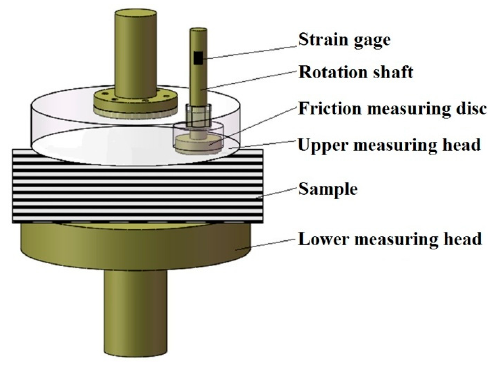
Figure 2. Surface smoothness measurement.